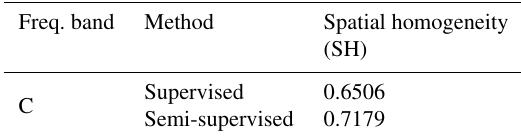
Table 5. Albis C-band radar – comparison of semi-supervised ap- proach with its supervised counterpart, spatial homogeneity. Freq.